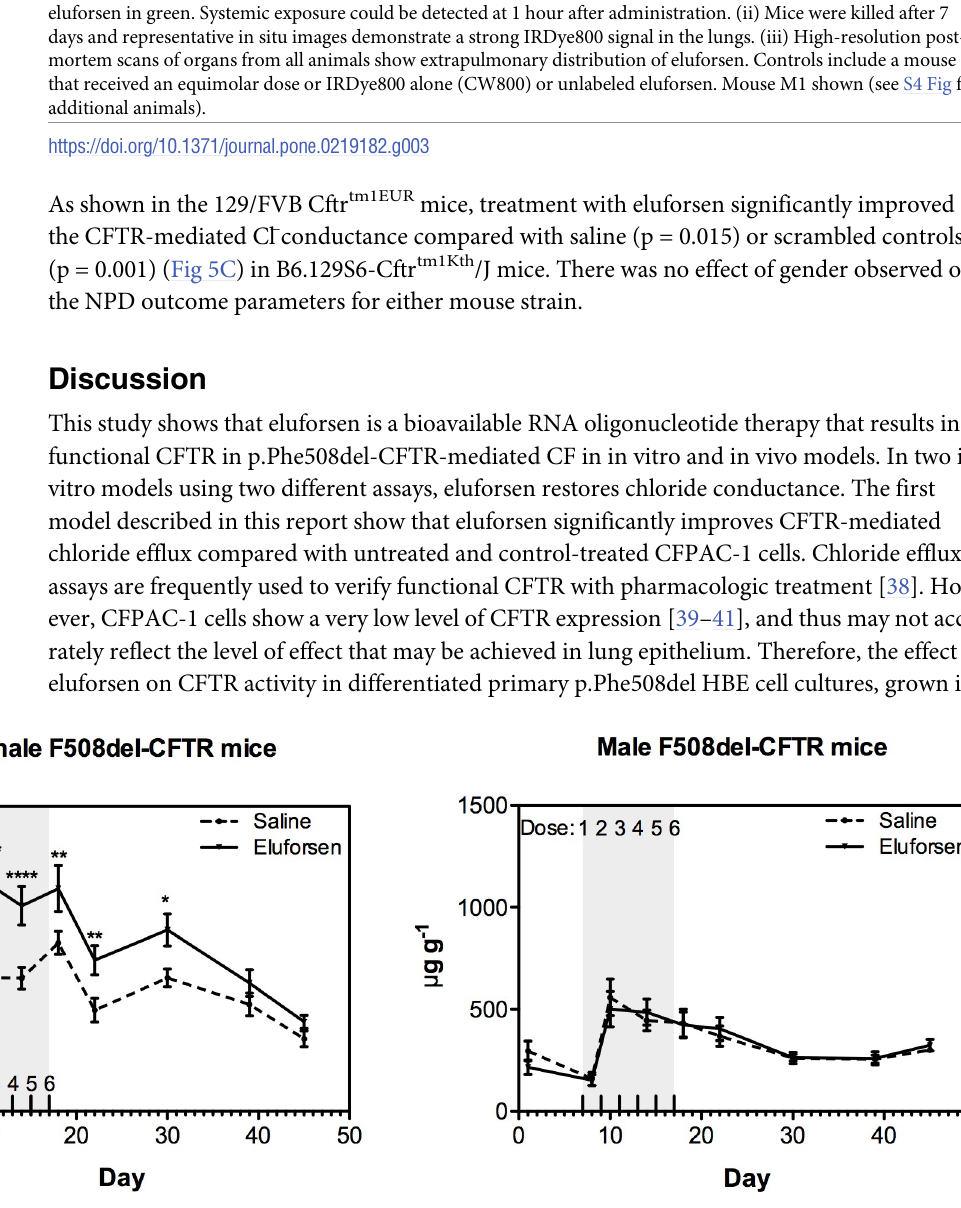
Fig 3. In vivo imaging and post-mortem detection demonstrate systemic exposure after OT administration of labeled eluforsen. (A) Representative confocal images of lung paraffin sections of wild-type (WT) mice following a single OT administration of 10 mg/kg Cy5-labeled eluforsen (shown in red) and killed after 24 hours, 48 hours, 3 days, 7 days, and 14 days. The cell nucleus was stained with DAPI (shown in blue). Macrophages accumulate the Cy5-labeled eluforsen and are visible as highly fluorescent spherical cells (as indicated with the yellow arrows). (B) (i) Representative in vivo images at several time points showing the IRDye800 (CW800) signal from IRDye800-labeled eluforsen in green. Systemic exposure could be detected at 1 hour after administration. (ii) Mice were killed after 7 days and representative in situ images demonstrate a strong IRDye800 signal in the lungs. (iii) High-resolution post- mortem scans of organs from all animals show extrapulmonary distribution of eluforsen. Controls include a mouse that received an equimolar dose or IRDye800 alone (CW800) or unlabeled eluforsen. Mouse M1 shown (see S4 Fig for additional animals).